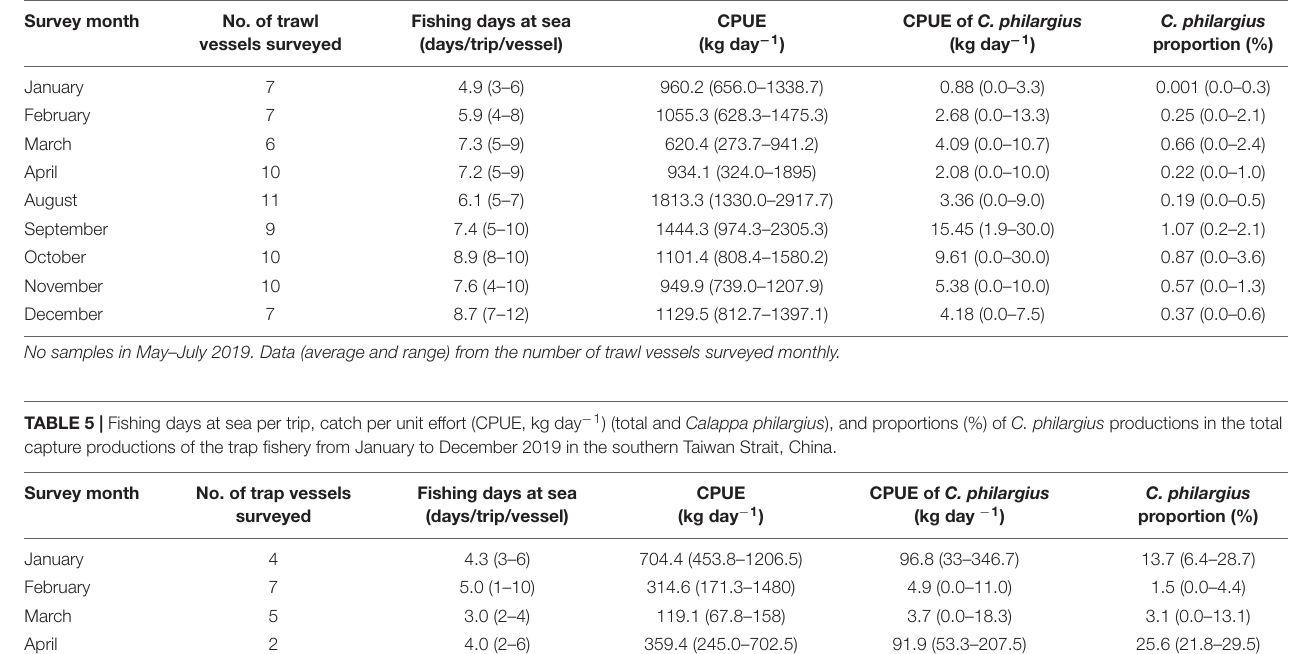
TABLE 4 | Fishing days at sea per trip, catch per unit effort (CPUE, kg day − 1 ) (total and Calappa philargius ), and proportions (%) of C. philargius productions in the total capture productions of the trawl fishery from January to December 2019 in the southern Taiwan Strait,